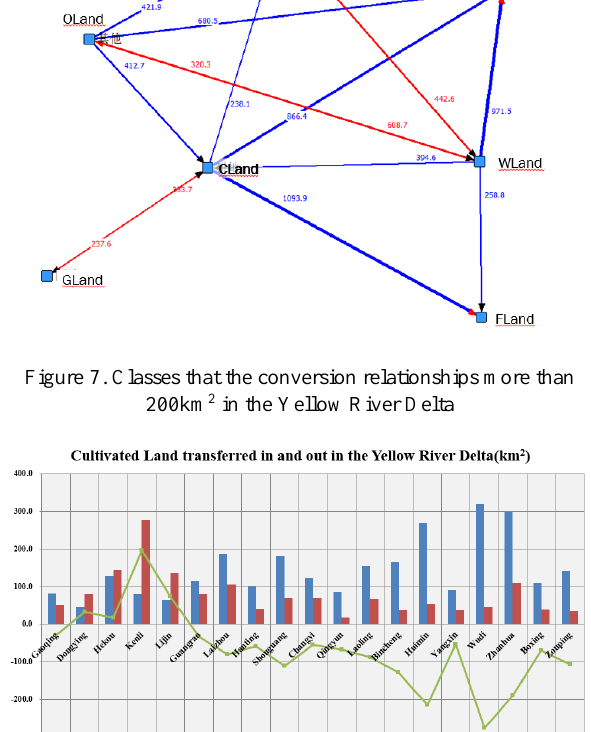
Figure 9. In the monitoring process, through the analysis of multiple periods of data transformation, hot spots and key